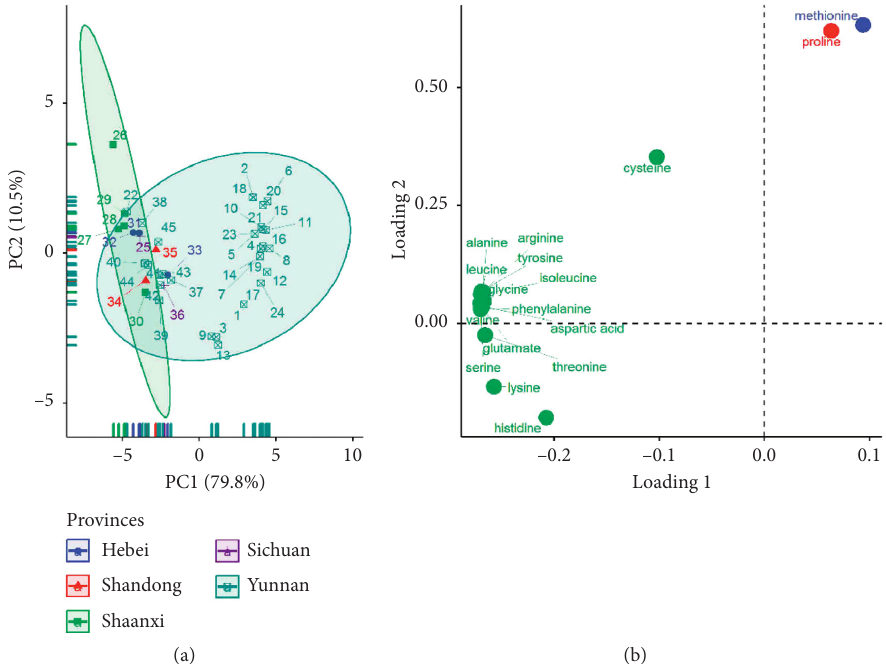
Figure 7: (a) PCA score of 45 different types of walnut kernels from the main five walnut-planting provinces in China. (b) PCA loading of the 17 amino acids in 45 different types of walnut kernels. The first three significant contributed amino acids were labeled with colors.